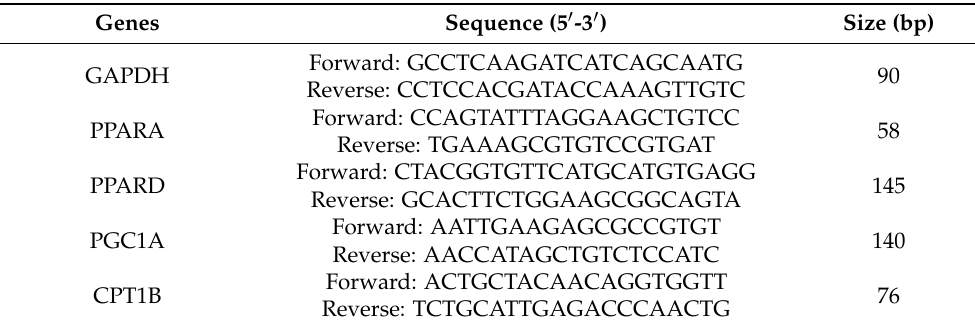
Table 1. Primers used for